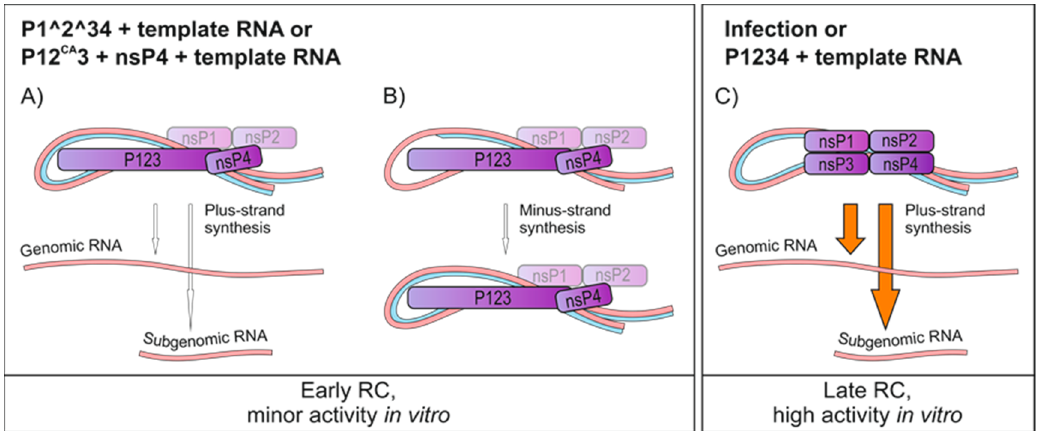
Figure 8. Schematic representation of the possible activities of various RCs that can be produced with the trans-replication system. ( A , B ) When cells are transfected with the partially uncleavable replicase and template constructs, PNS shows very little activity in vitro indicated by the white arrows. A minor amount of plus-strand RNA is made, and it is also possible that RCs finish initiated minus strands. These complexes represent early RCs; ( C ) when cells are infected or transfected with the wild-type replicase and template constructs, the prepared PNS is highly active in vitro and synthesizes RNA of positive polarity, both genomic and subgenomic, indicated by the orange arrows. These complexes are late